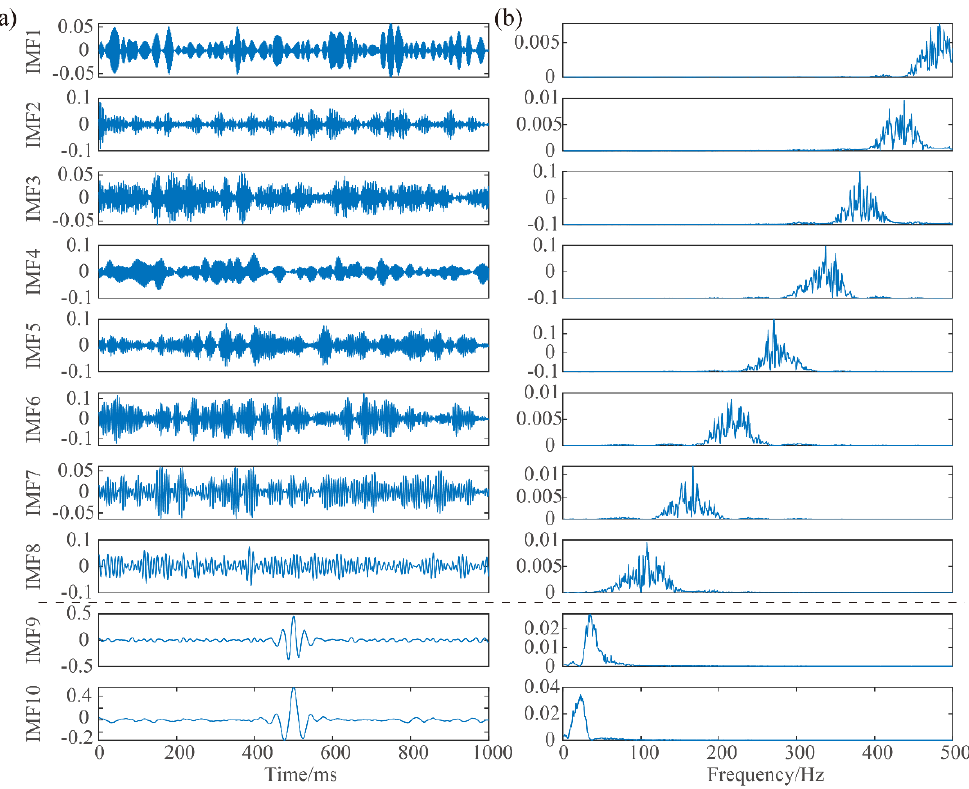
Figure 5. Waveforms and spectrograms of ten components obtained by variational mode decomposition (VMD). ( a ) Waveforms of components; ( b ) spectrograms of components.